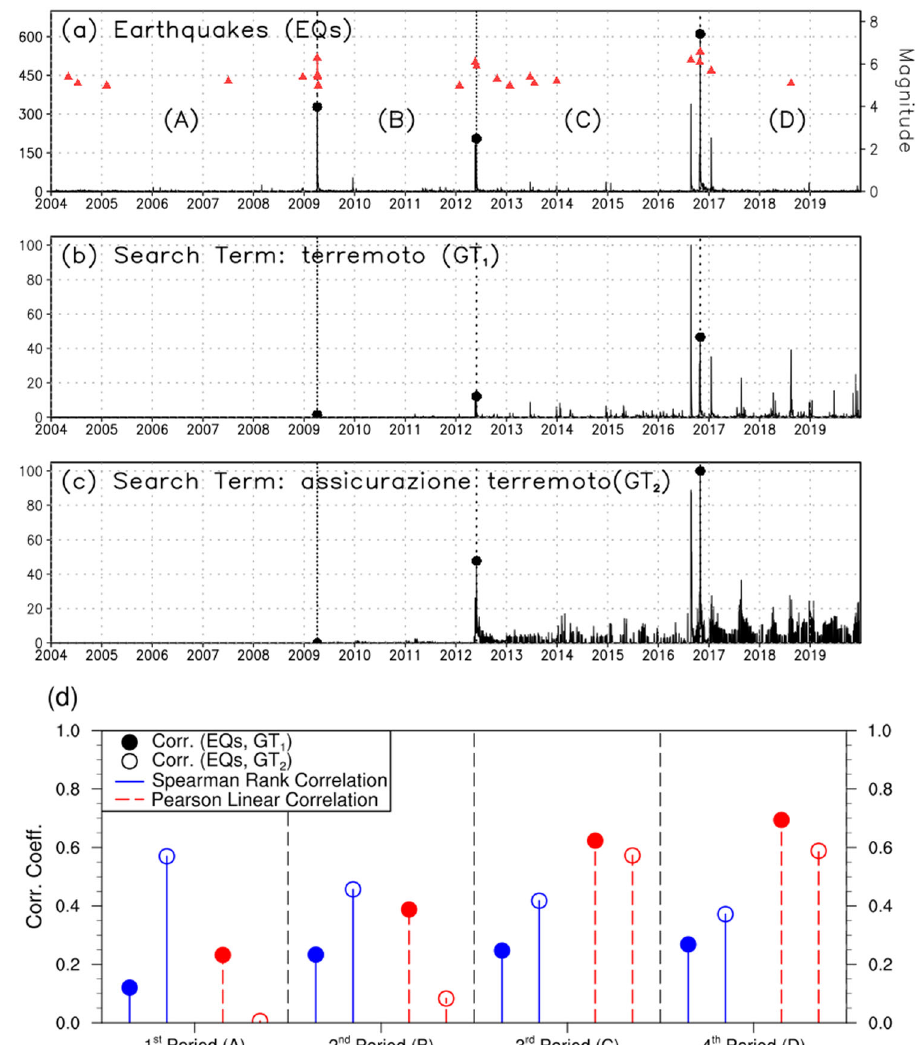
Fig. 1 Earthquakes and Google Trends data considered for the period (2004-2019) under investigation in the article. a Triangles: daily earthquakes ( M ≥ 5.0) (data from Rovida et al. (2019) for 2004 – 2017, from http://terremoti.ingv.it/ for years 2018 – 2019, in case of multiple events the same days plots refer to the maximum magnitude of that day), bars: daily number of earthquakes; b , c weighted daily time series of Google Trends (DGT) data using the two search options; d correlation between DGT data and daily